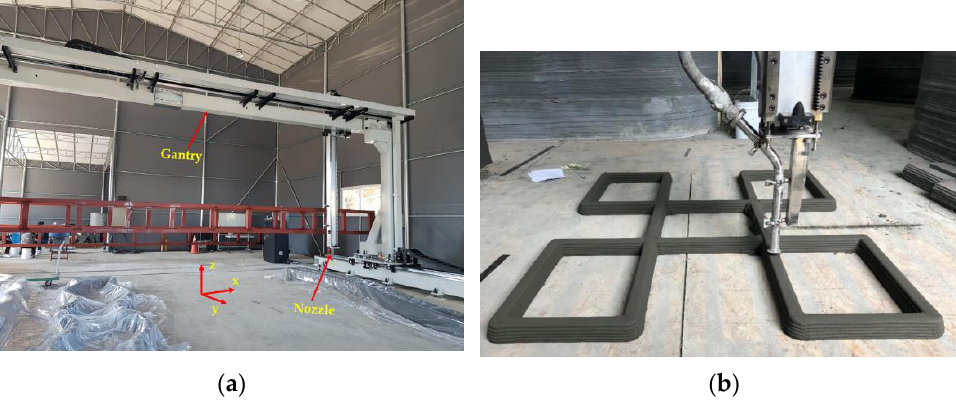
Figure 2. 3D-printing system. ( a ) Printing gantry system; ( b ) Printing nozzle.